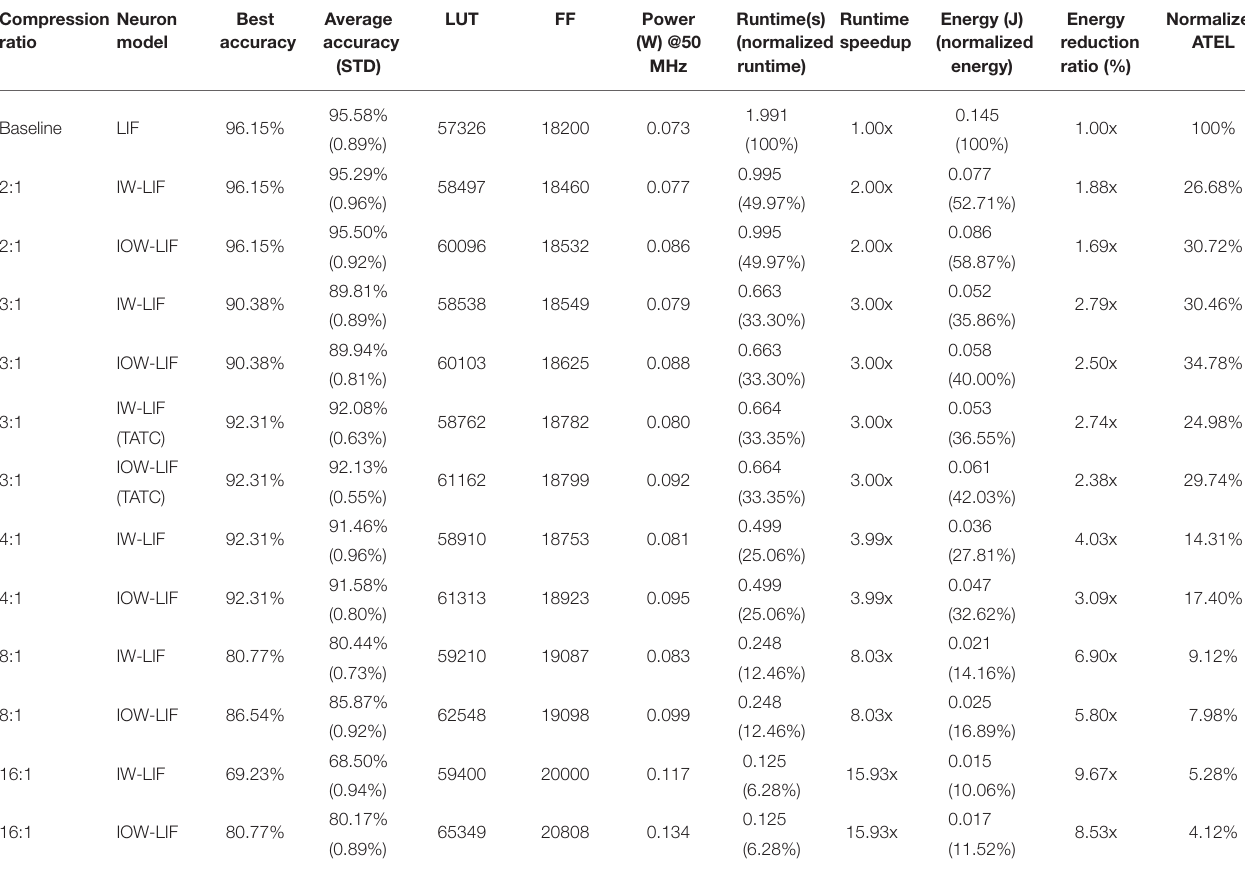
TABLE 1 | Comparison of the baseline and TC-SNN accelerators with IW/IOW LIF neurons based on TI46 Speech Corpus. Compression Neuron ratio